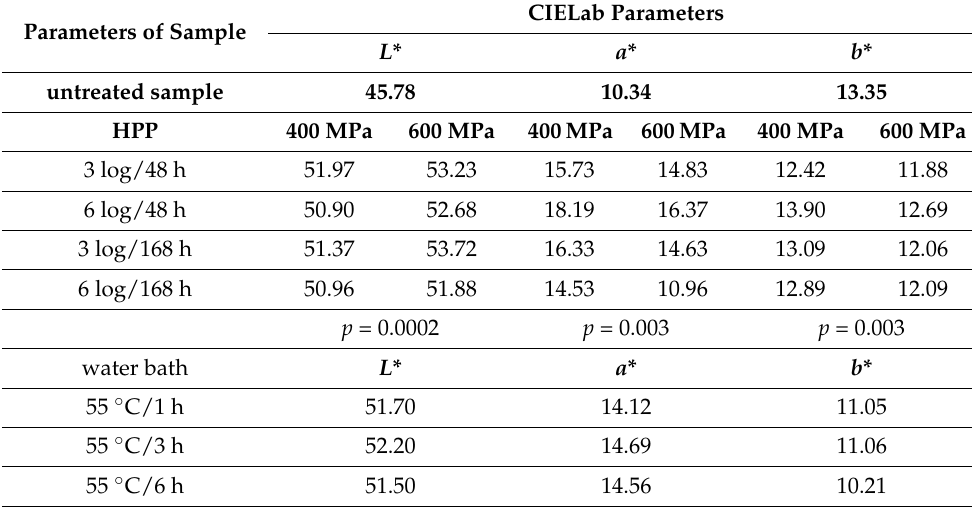
Table 4. Values of L *, a *, b * during instrumental analysis of the color (CIELab) of samples of the product steak tartare treated by HPP (high-pressure processing) at 400 and 600 MPa or heat-treated at 55 ◦ C. CIELab Parameters Parameters of Sample L * untreated